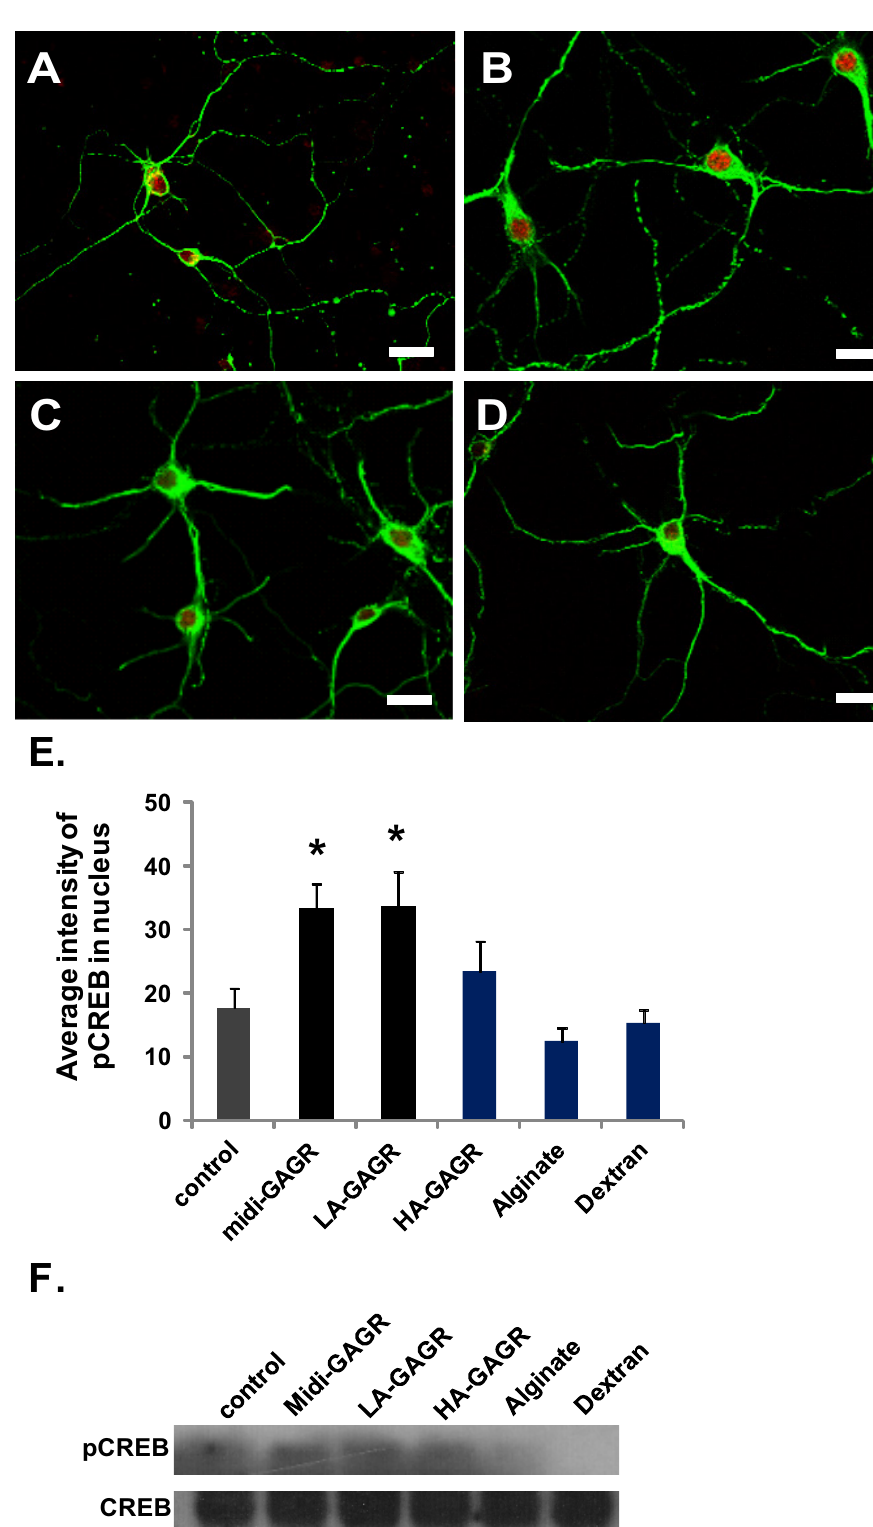
Fig 8. Midi-GAGR activates CREB, a neurotrophic transcriptional factor. Mouse cortical neurons (DIV4) were treated with H 2 O (vehicle), 1 μ M midi-GAGR, 0.1 μ M LA-GAGR, 0.01 μ M HA GAGR, 1 μ M alginate, or 1 μ M dextran for 48 h and immunostained with DAPI (not shown) and the antibodies to α -tubulin and